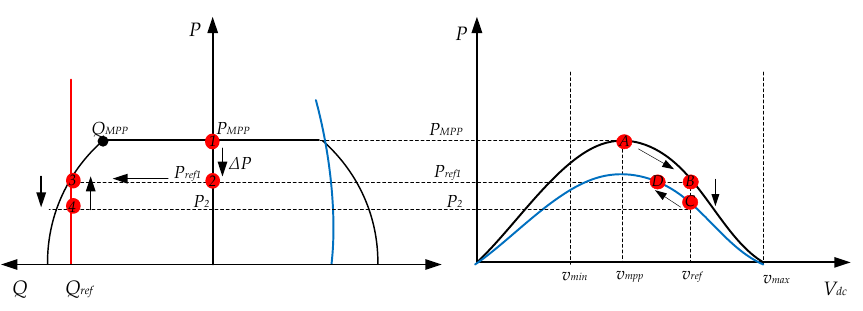
Figure 16. QPPT operation in a variable PQ and ambient conditions: Absorption of reactive power. (1) MPP at one solar irradiance, (2) Variation of active power reference, (3) Reference of reactive power, (4) New active and reactive power